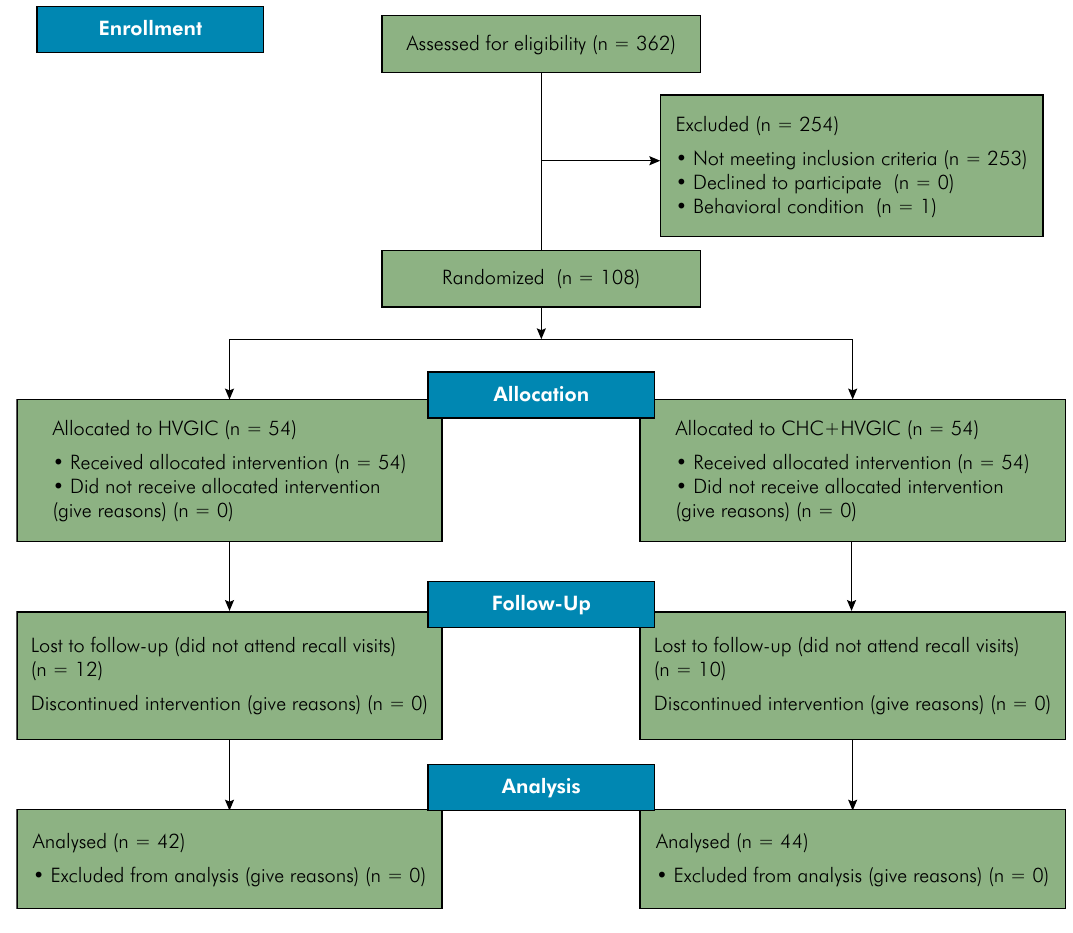
Figure 1. Flow chart of participants through the study